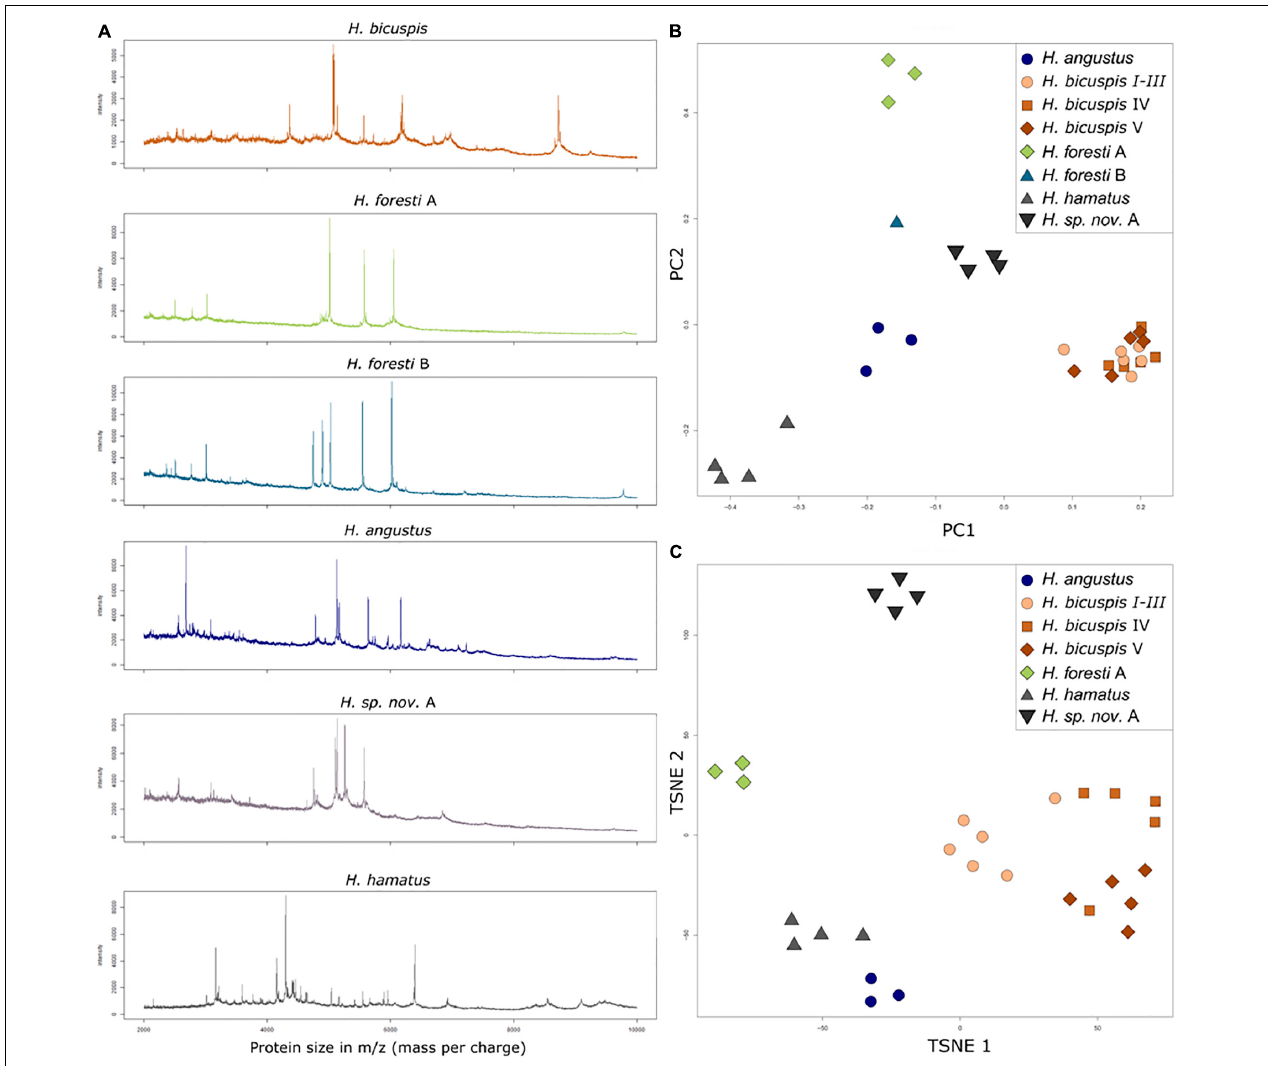
FIGURE 7 | Results of the MALDI-TOF MS measurements. (A) Mass spectra of different species colored according to the species colors in the TSNE plots. Because of the high similarity between the three H. bicuspis lineages, only a single spectrum is shown for this morphotype. (B) PCA of the hellinger transformed raw data. (C) Rf